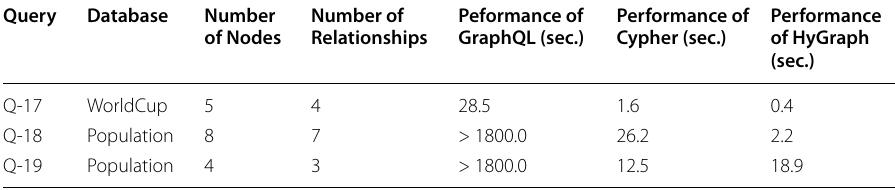
The timings are given in terms of seconds (sec.)